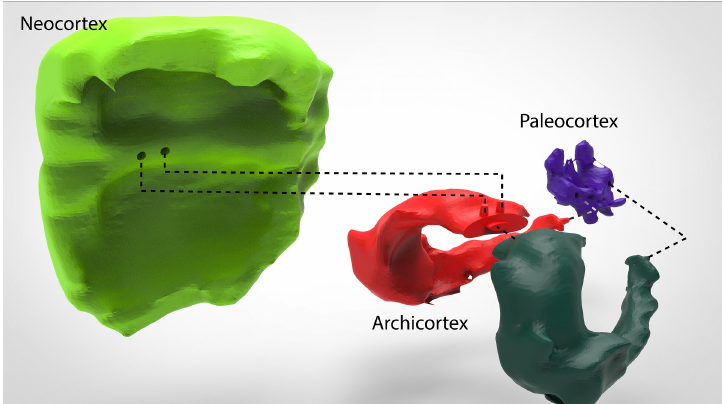
Figure 5. Interconnecting joins. Figure shows the interconnecting joins among three parts of the brain 3D model. It is possible to appreciate that the Neocortex, as well as the Paleocortex, has two depressions. These depressions fit perfectly with the protuberances on the top of the